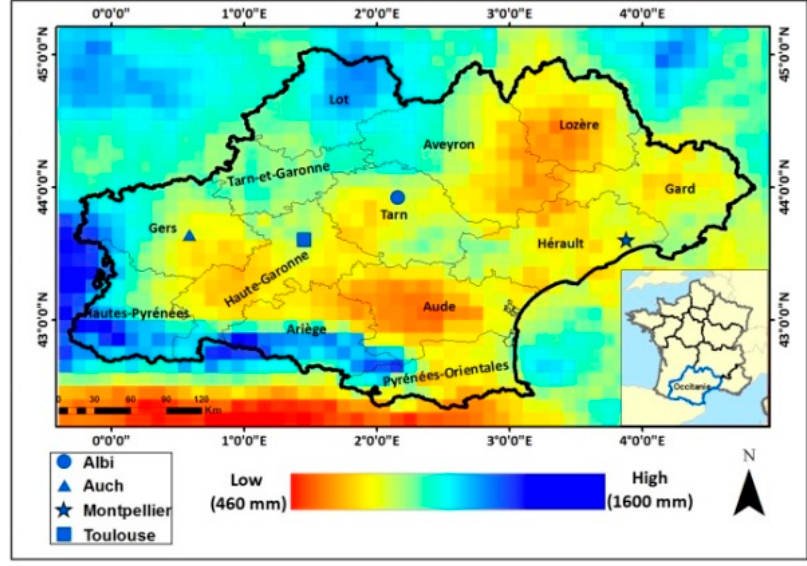
Figure 1. Annual cumulative precipitation calculated using Integrated Multi-satellite Retrievals for Global Precipitation Measurement (IMERG-GPM) data over the study site (Occitanie region, South France) between 1 September 2016 and 31 August 2017. Black lines represent the department limits according to French administrative nomenclature.